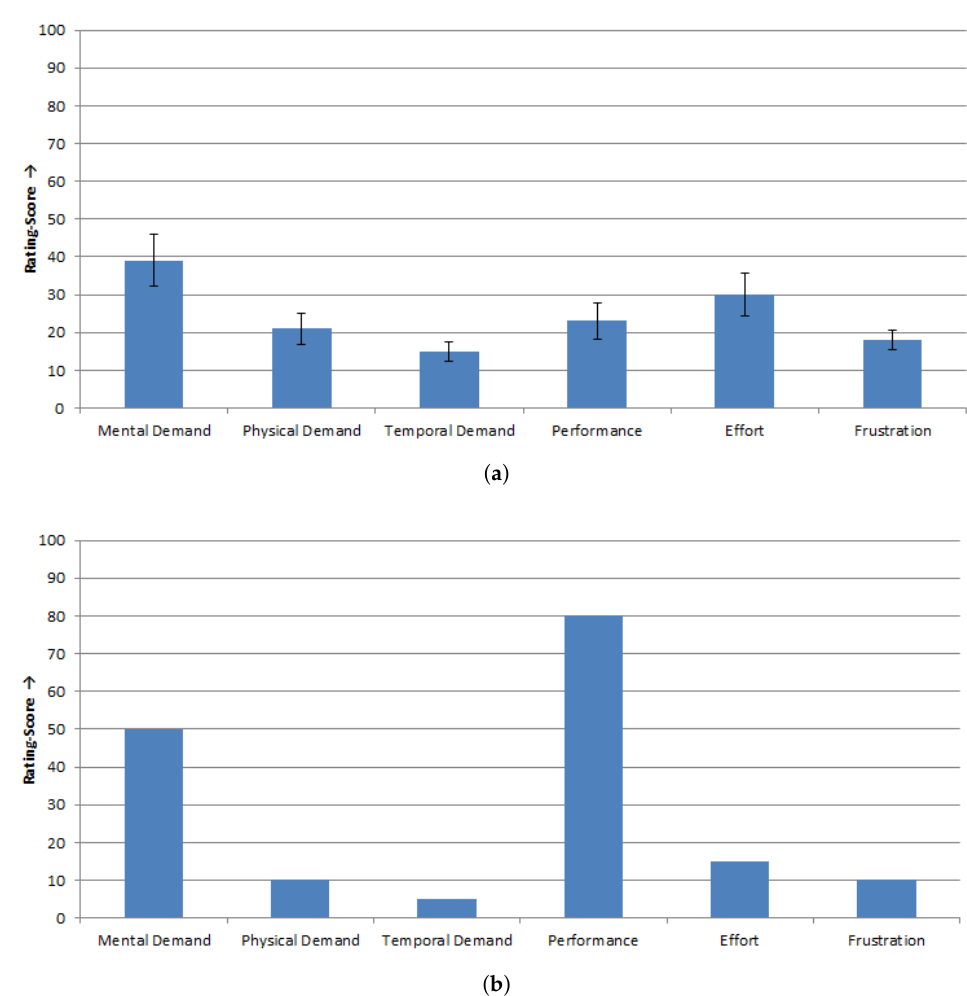
Figure 10. Results of the NASA-TLX questionnaire to measure the subjectively perceived workload for the use-case, scale: 0 = low/good to 100 = high/poor: ( a ) able-bodied subjects ( n = 10), mean values ± SE of the rating scores for the six sub-scales of the NASA-TLX; and ( b ) subject with tetraplegia ( n = 1), Values of the rating scores for the six sub-scales of the